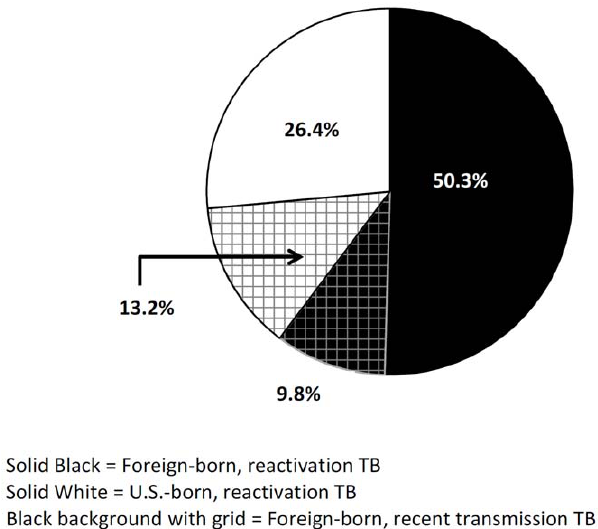
Figure 1. Tuberculosis attributed to recent transmission versus reactivation of remote tuberculosis infection by nativity, United States 2005–2009. Legend: Solid black=Foreign-born, reactivation TB Solid white=U.S.-born, reactivation TB Black back- ground with grid=Foreign-born, recent transmission TB White back- ground with grid=U.S.-born, recent transmission